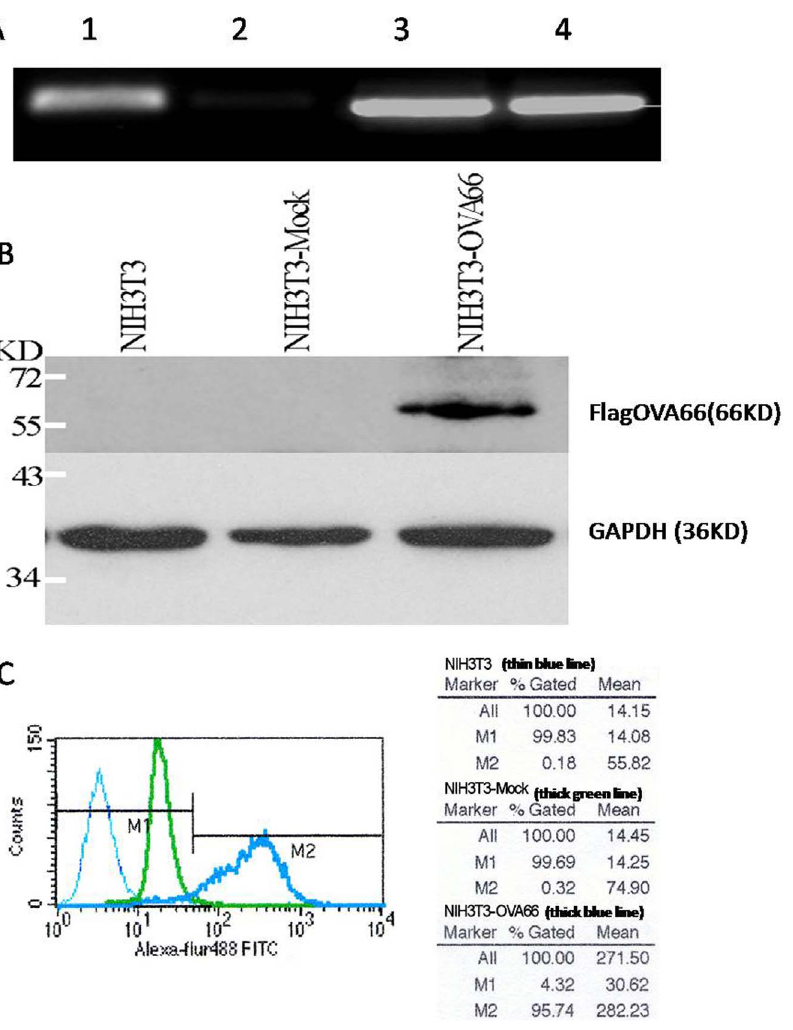
Figure 1. NIH3T3-flagOVA66 cells showed a stably expression of OVA66 mRNA and protein. A. OVA66 mRNA level was examined by RT- PCR. Lane 1 and 2, OVA66 of NIH3T3-flagOVA66 and NIH3T3-mock; Lane 3 and 4, GAPDH of NIH3T3-flagOVA66 and NIH3T3-mock cells. B. Western blot analysis of flagOVA66 protein level in NIH3T3-flagOVA66 cells. C. Quantization of OVA66 protein by FACS analysis using intracellular staining. The thick blue line indicated the expression of OVA66 in NIH3T3-flagOVA66 cells.